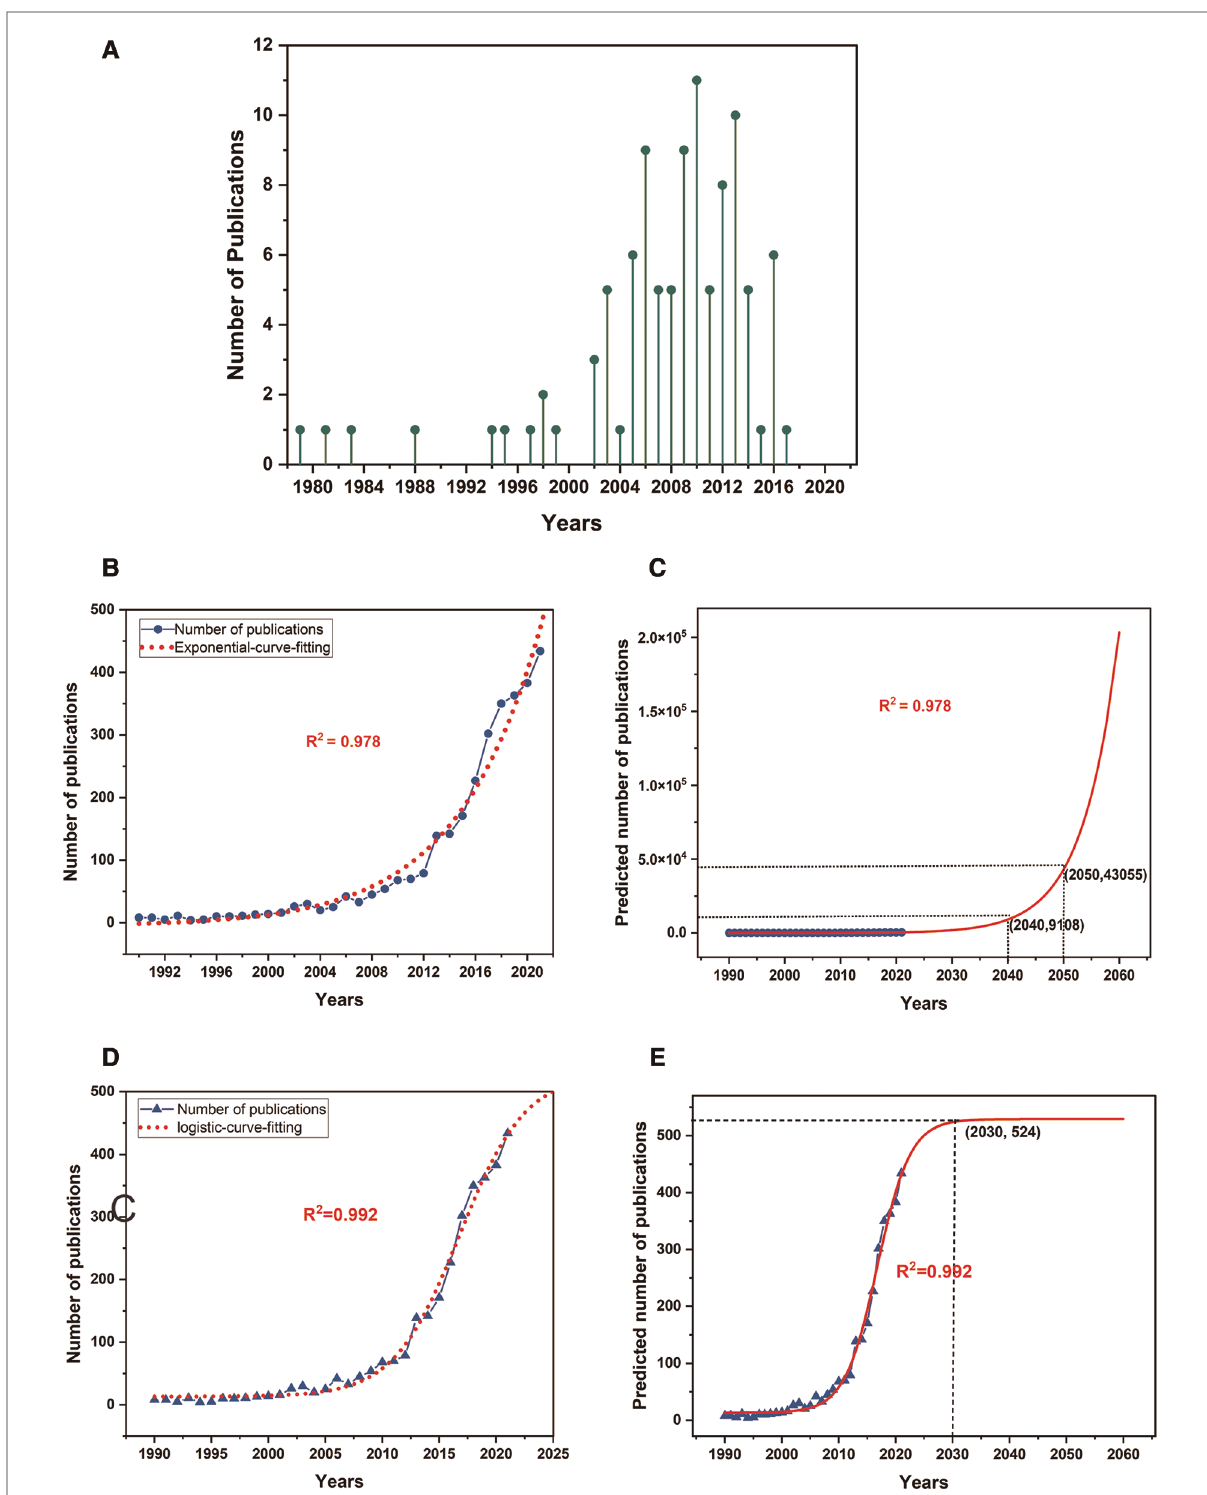
FIGURE 9 The distribution of the top 100 most-cited articles on ASD ( A ). Model of exponential fi tting curves of the trends in publications related to ASD research per year ( B,C ). Model of logistic regression fi tting curves of the trends in publications related to ASD research per year ( D,E